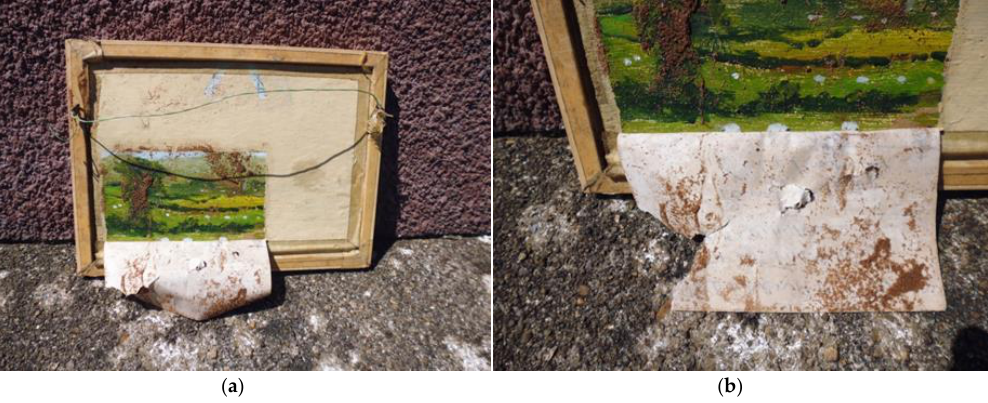
Figure 16. ( a ) Backing falls away; ( b ) Indecipherable writing.